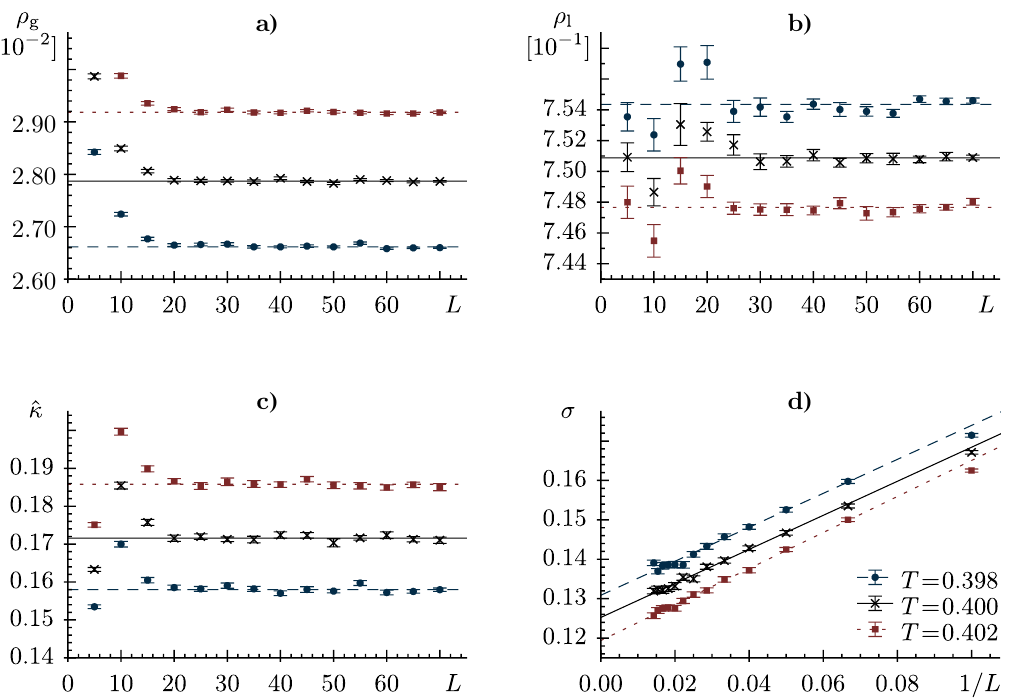
Figure 5: Grand canonical observables at fixed T = 0.398 (blue circles, dashed lines), T = 0.400 (black crosses, solid lines) and T = 0.402 (red squares, dotted lines):